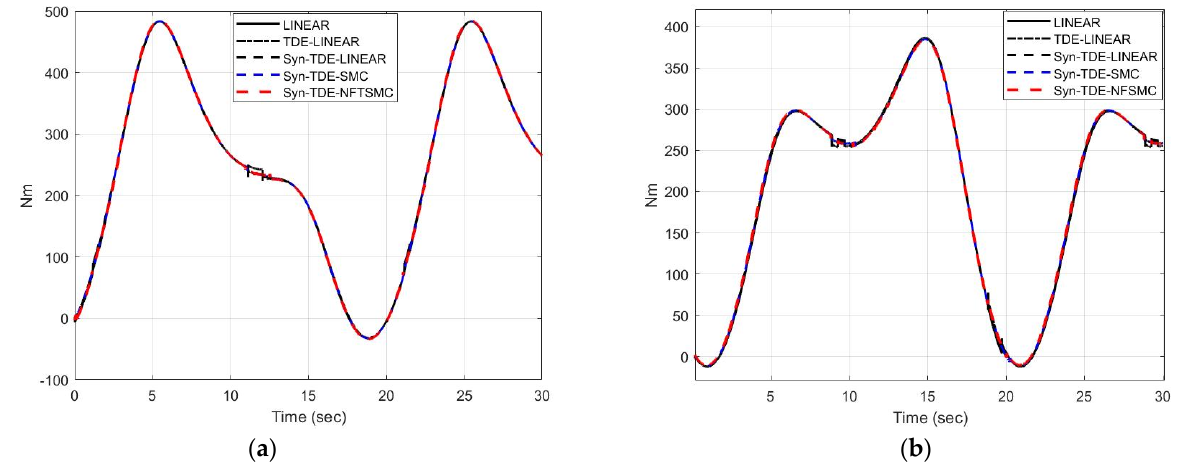
Figure 9. The control input signals of the control schemes of joint 1 ( a ) and joint 2 ( b ).